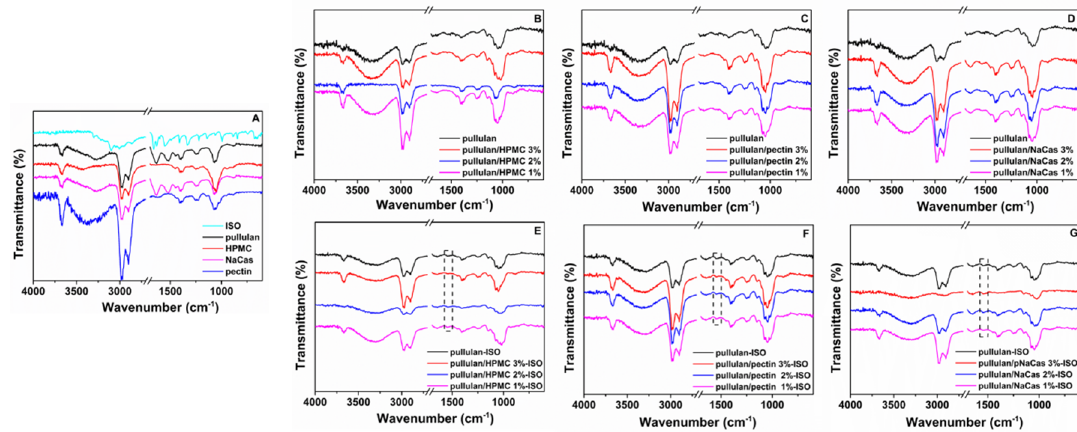
Figure 5. FTIR spectra of the ( A ) raw materials, the plain ODFs containing ( B ) HPMC, ( C ) pectin and ( D ) NaCas, and the ISO-loaded ODFs containing ( E ) HPMC, ( F ) pectin and ( G ) NaCas.